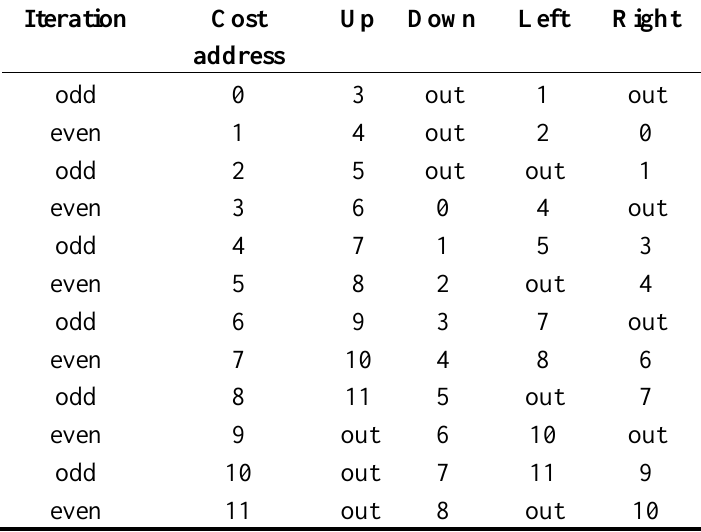
Table 2. Address generation for the